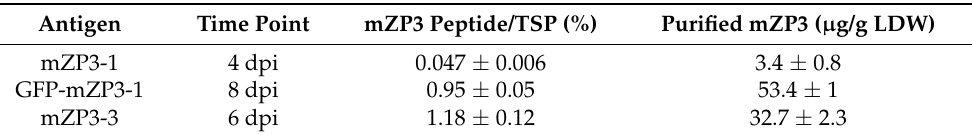
Table 1. mZP3 accumulation levels in crude plant extract and in purified antigens, as determined using ELISA